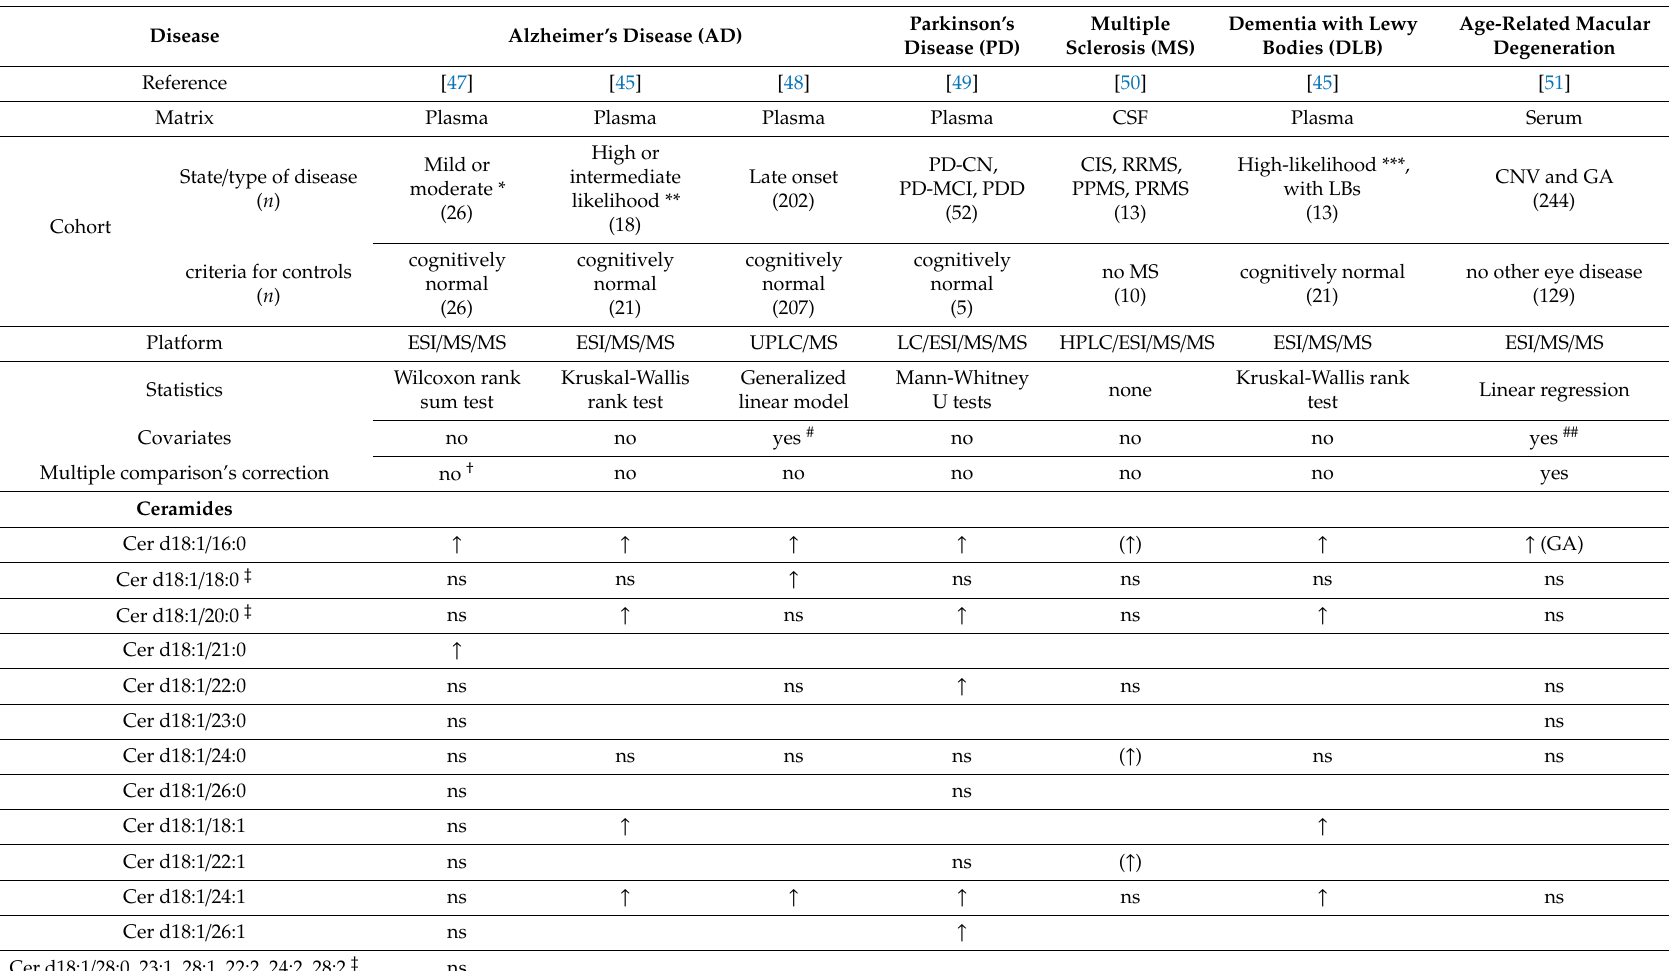
Table 2. Comparison of case-control lipidomic studies reporting alterations of ceramide species in neurodegenerative diseases. Disease Alzheimer’s Disease (AD)